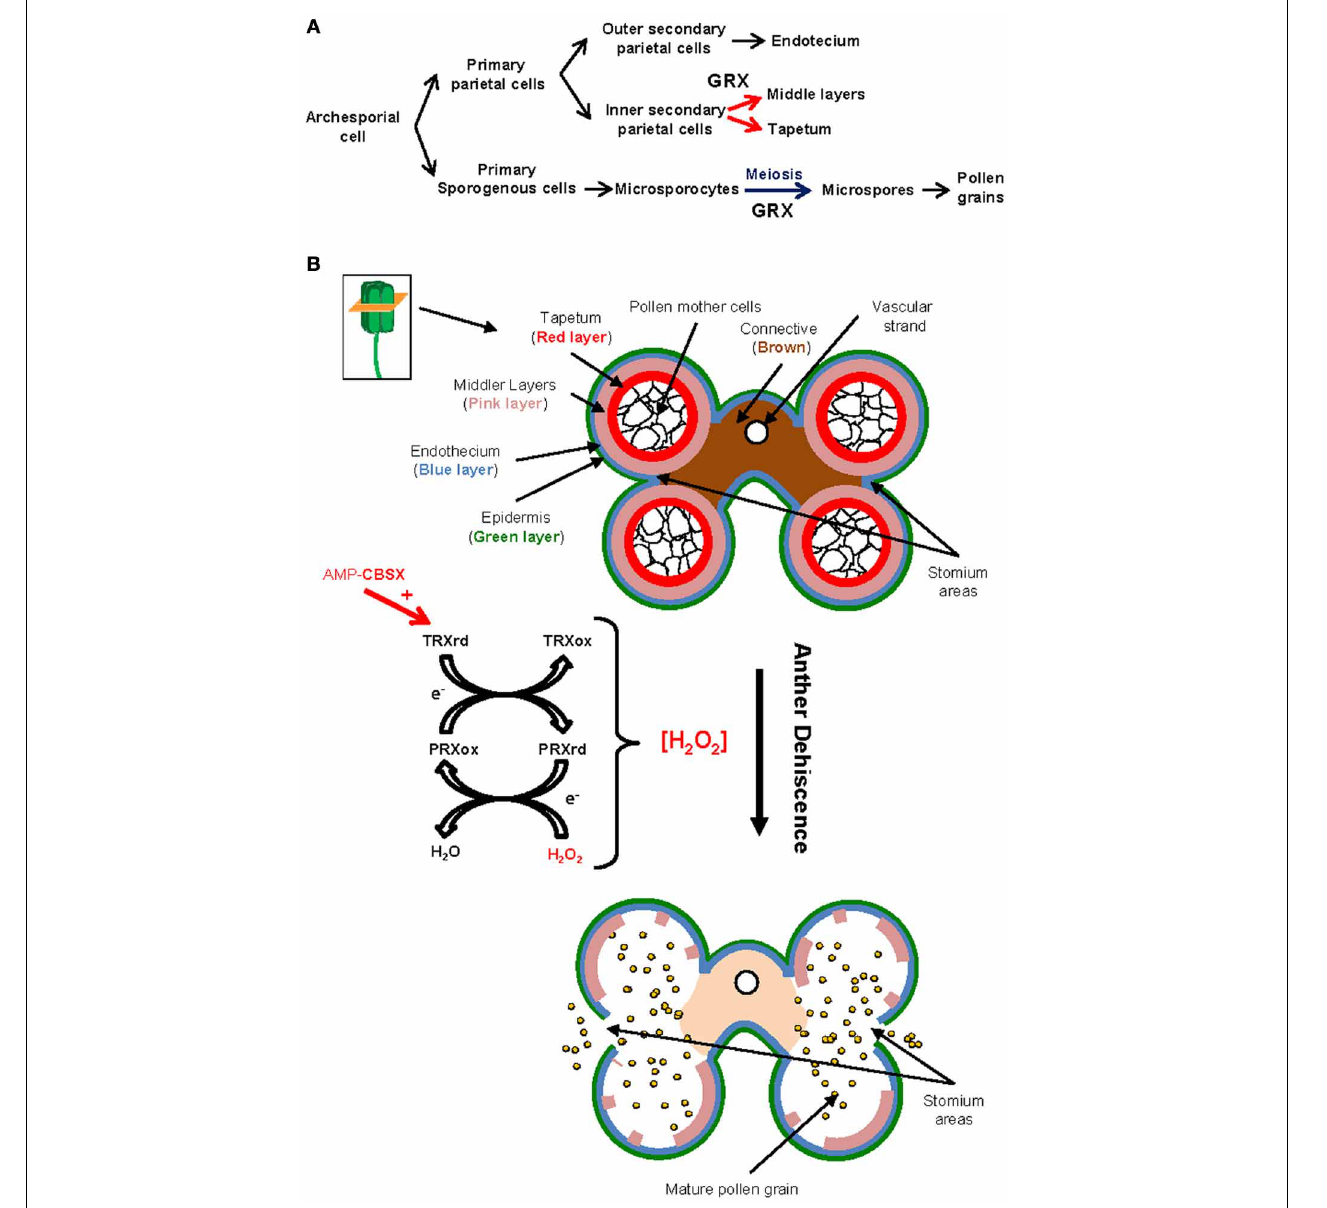
FIGURE 2 | Thiol-based redox proteins are critically involved in male gametogenesis, anther development and dehiscence. (A) Ontogenic development of the male germline. CC-type GRXs are essential for the switch from mitosis to meiosis in the microsporocytes (blue arrow), which ultimately originate the haploid pollen grains. They also participate in the development of the anther layers surrounding the microsporocytes (red arrows). (B) Diagram representing the histological